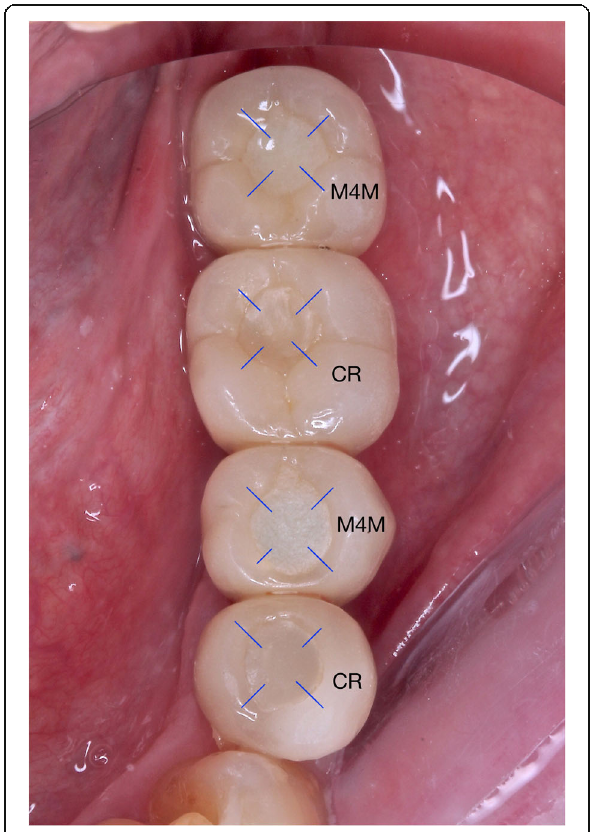
Fig. 4 Margin depth measurement localization (example: TRA, T = 12 M) Fig. 5 Depth and angle at the